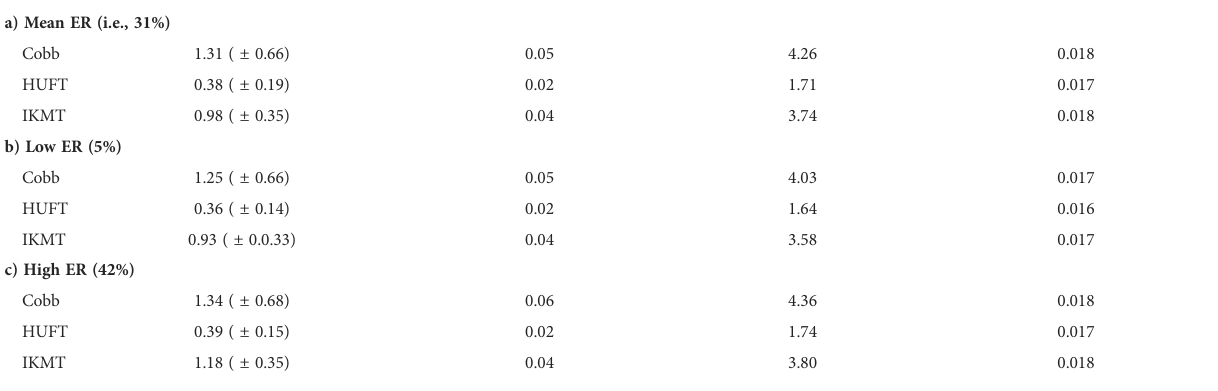
TABLE 3 Micronekton mean, minimum, and maximum active carbon transport [ACT; ± standard error of the mean (SEM)] and mean ACT per unit biomass using the Cobb (N = 7), HUFT (N = 12), and IKMT (N = 11), calculated using three different excretory ratios [i.e., 31%, 5%, and 42%; as per Steinberg et al.